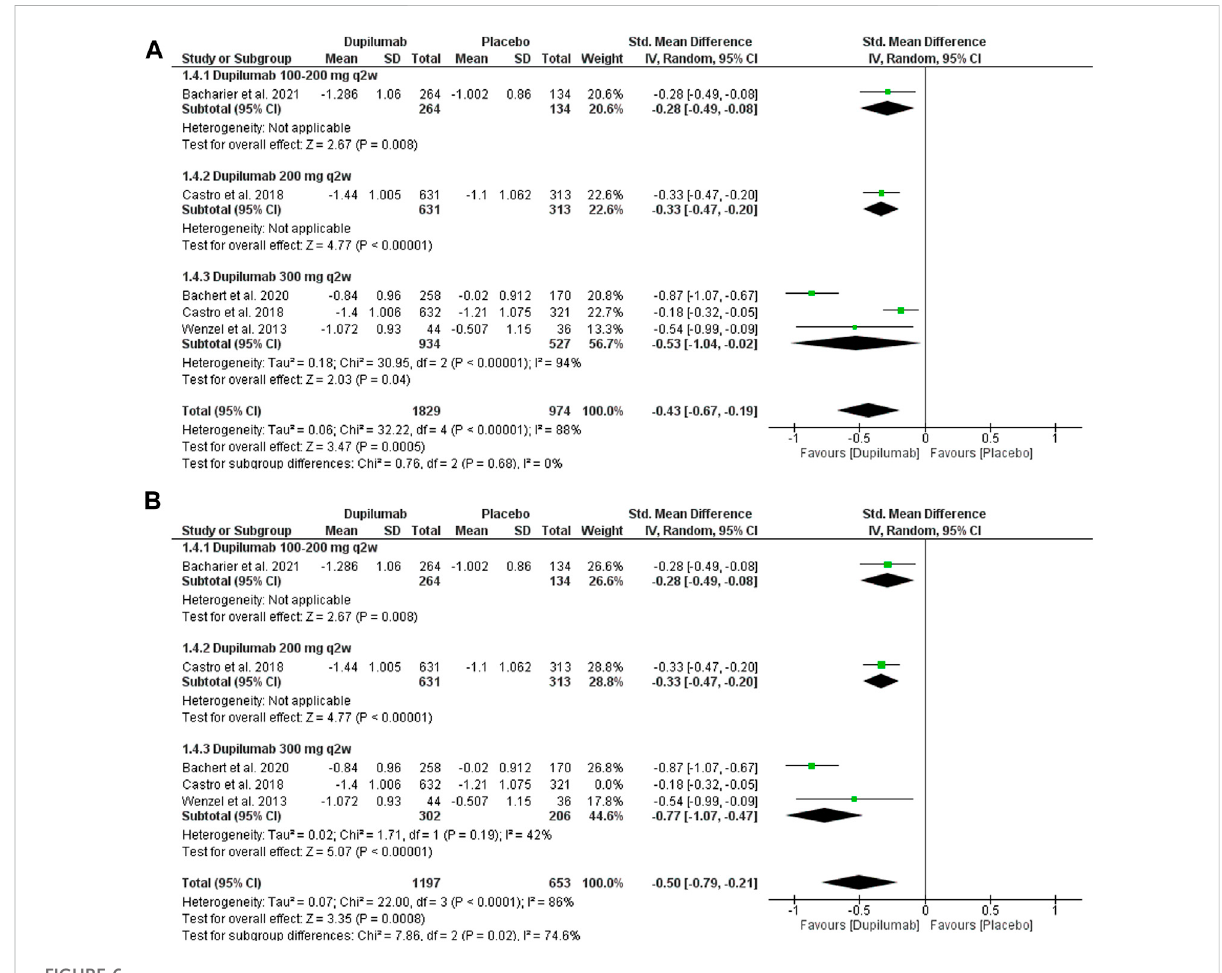
FIGURE 6 Results of the ACQ change at the 24th week. (A) Before sensitivity analysis. (B) After sensitivity